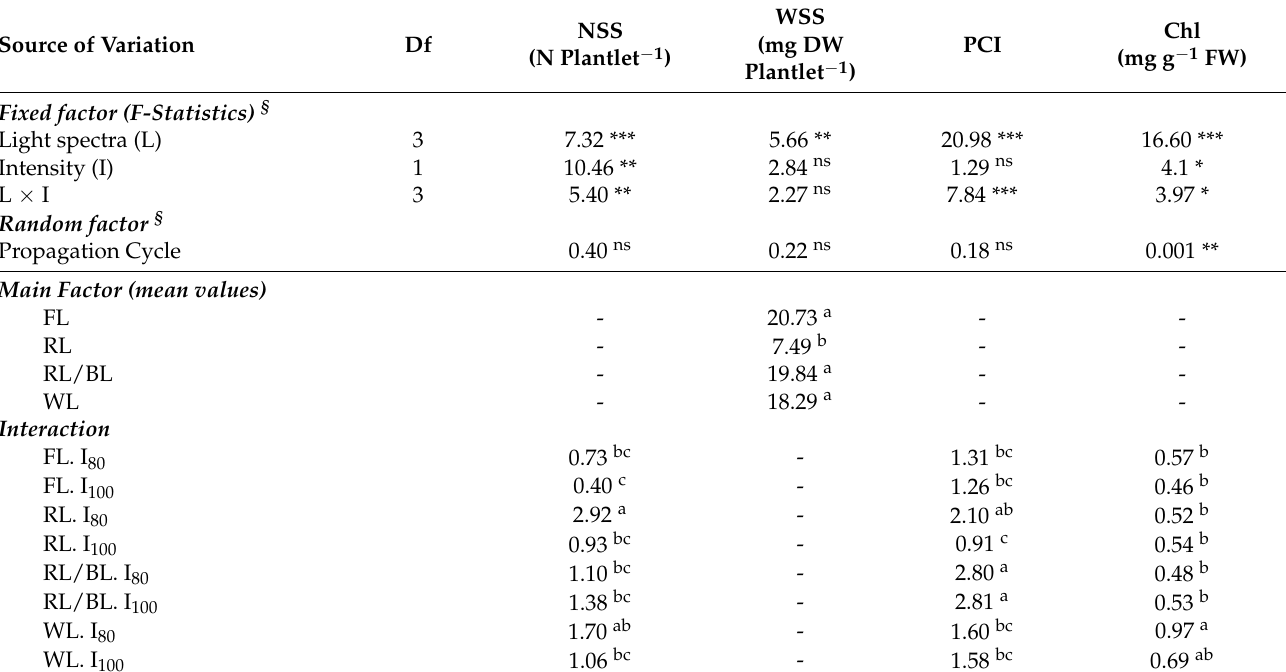
Table 1. Mixed model ANOVA (F-statistics) and means of four light spectra (L), two light intensities (I), and propagation cycle for number of secondary shoots (NSS), weight of secondary shoots (WSS), projected canopy index (PCI), and leaflets’ chlorophyll concentration (Chl a+b ) of